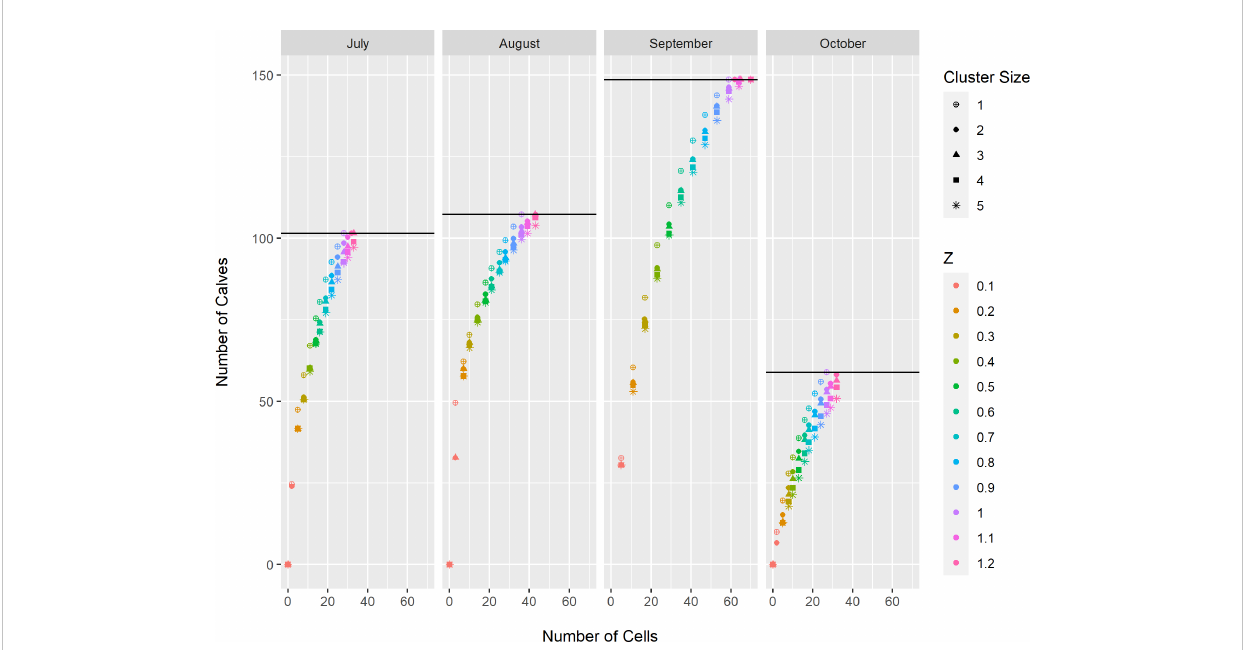
FIGURE 3 Estimated number of bowhead whale calves (Eqn. 1) enclosed by Biologically Important Areas for spatial optimization models constructed for each month (July-October), minimum contiguity threshold (cluster size 1-5), and maximum occupied area threshold (Z = 0.1, 0.2, 0.3, 0.4, 0.5, 0.6, 0.7, 0.8, 0.9, 1.0, 1.1, 1.2). The black horizontal line in each column represents the total number of observed bowhead whale calves for that